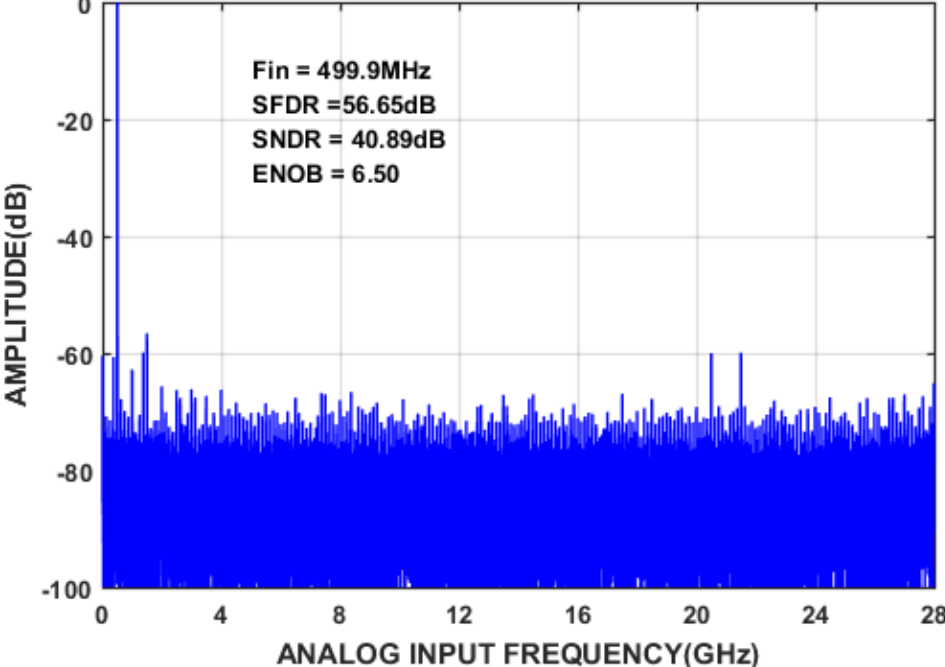
Figure 13. Measured output spectrum when the input frequency is 499.9 MHz at a 56 GS/s sampling rate.